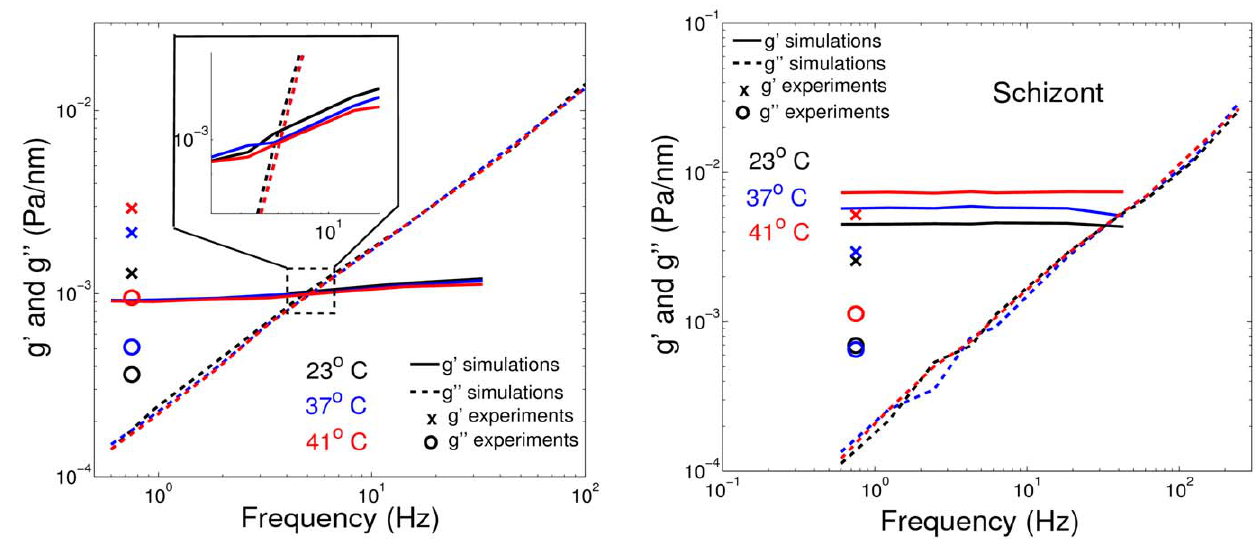
Figure 3. Components ( g ’ and g ’’ ) of the complex modulus for healthy RBCs (left) and Pf-RBCs at the schizont stage (right) for different temperatures. Experimental data [5] for the frequency 0 : 75 Hz are drawn in symbols. The shear moduli of Pf-RBCs for different stages and temperatures are given in Tables 1 and 2. The bending stiffness and the membrane viscosity in all cases are set to 2 : 4 | 10 { 19 J and 0 : 022 Pa : s , respectively.